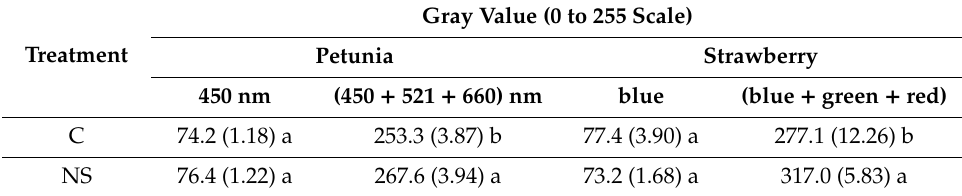
Table 3. Average gray values of blue and combined wavelengths in petunia (proof-of-concept experiment) and strawberry (product development experiment) under control (C) and nitrogen stress (NS) treatments. Treatment means followed by the same letter are not statistically different ( p ≤ 0.05). Values in parenthesis indicate standard error of mean.